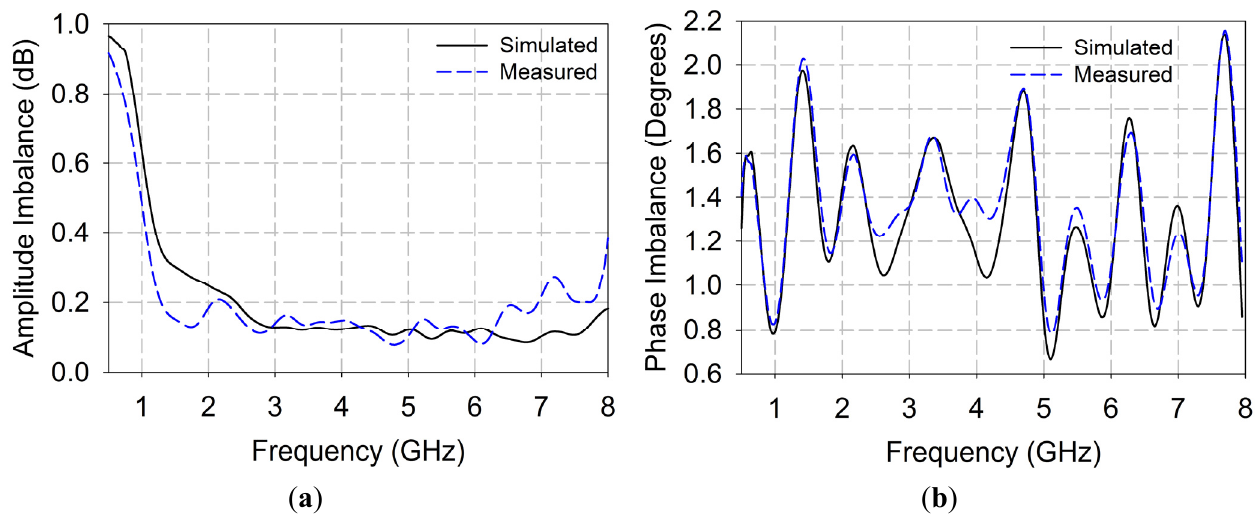
Figure 5. Simulated and measured imbalance: ( a ) magnitude; and ( b ) phase.